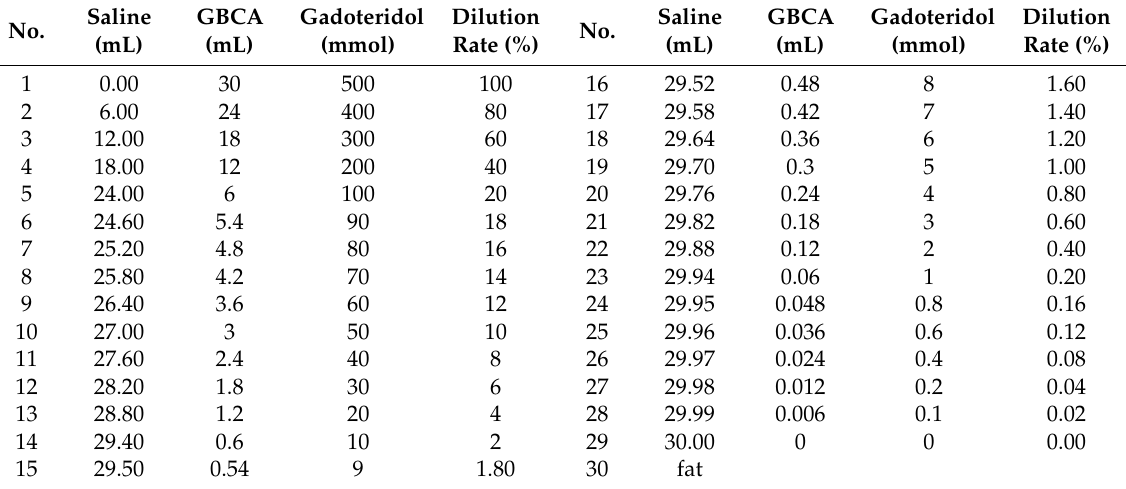
Table 1. GBCA concentration and dilution rate in the phantom study.